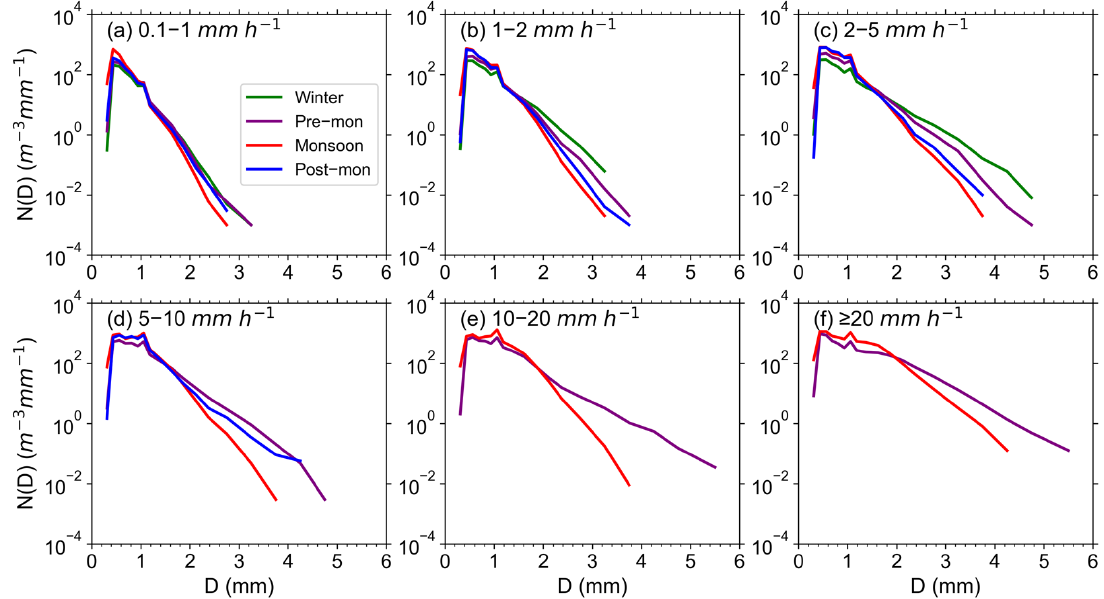
Figure 5. Averaged DSDs for different rain rate categories. ( a ) R1: 0.1 ≤ R < 1 mm h − 1 , ( b ) R2: 1 ≤ R < 2 mm h − 1 , ( c ) R3: 2 ≤ R < 5 mm h − 1 , ( d ) R4: 5 ≤ R < 10 mm h − 1 , ( e ) R5: 10 ≤ R < 20 mm h − 1 and ( f ) R6: R ≥ 20 mm h − 1 .